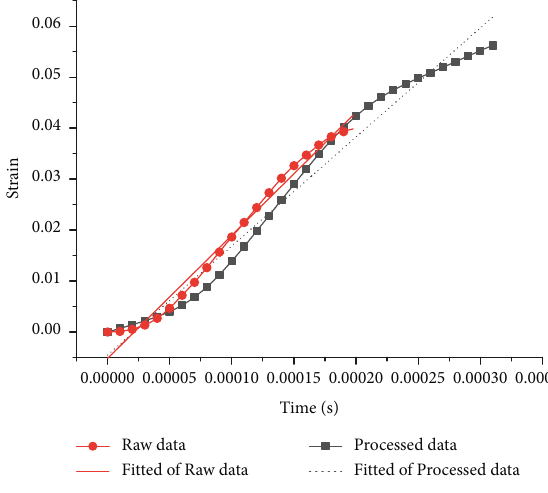
Figure 7: Typical strain rate changes before and after digital filtering.